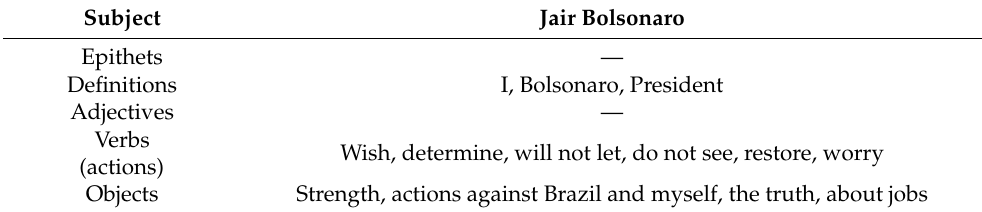
Table 16. Jair Bolsonaro.